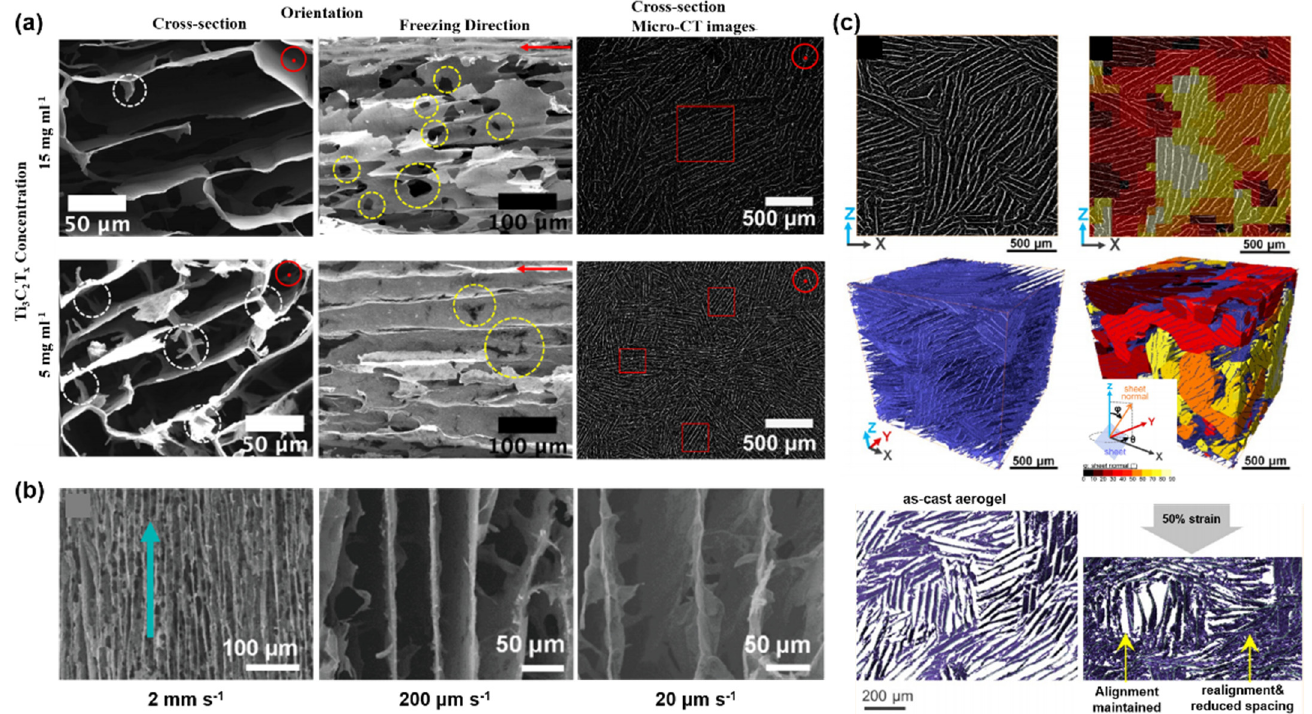
Figure 10. ( a ) SEM and Micro-CT images of MXene monoliths with local oriented lamellar structure showing the enlarged spacing of MXene hydrogels under reduced freezing rate. ( c ) Virtual CT section and 3D segmented rendering of the aerogel sheets (up left); virtual CT section and 3D segmented showing the domain orientations (up right); and microstructure evolution under compression